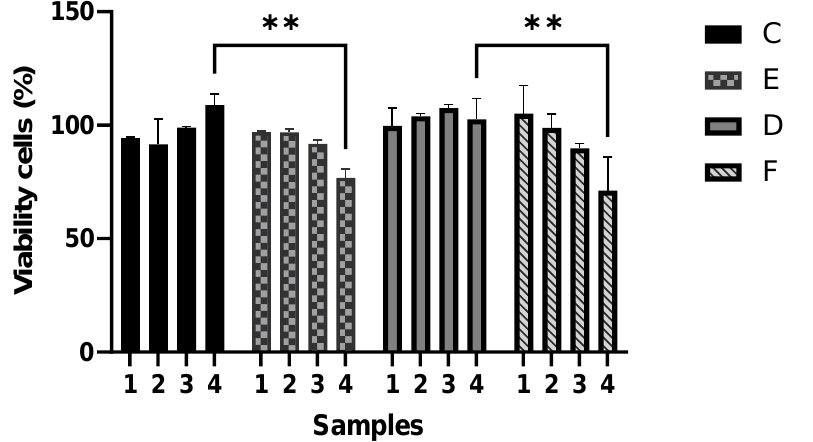
Figure 13. Cytotoxic effect of SAN0.5, SAN1.0, SAN/AA0.5 and SAN/AA1.0 composite series on A549 epithelial cell line.